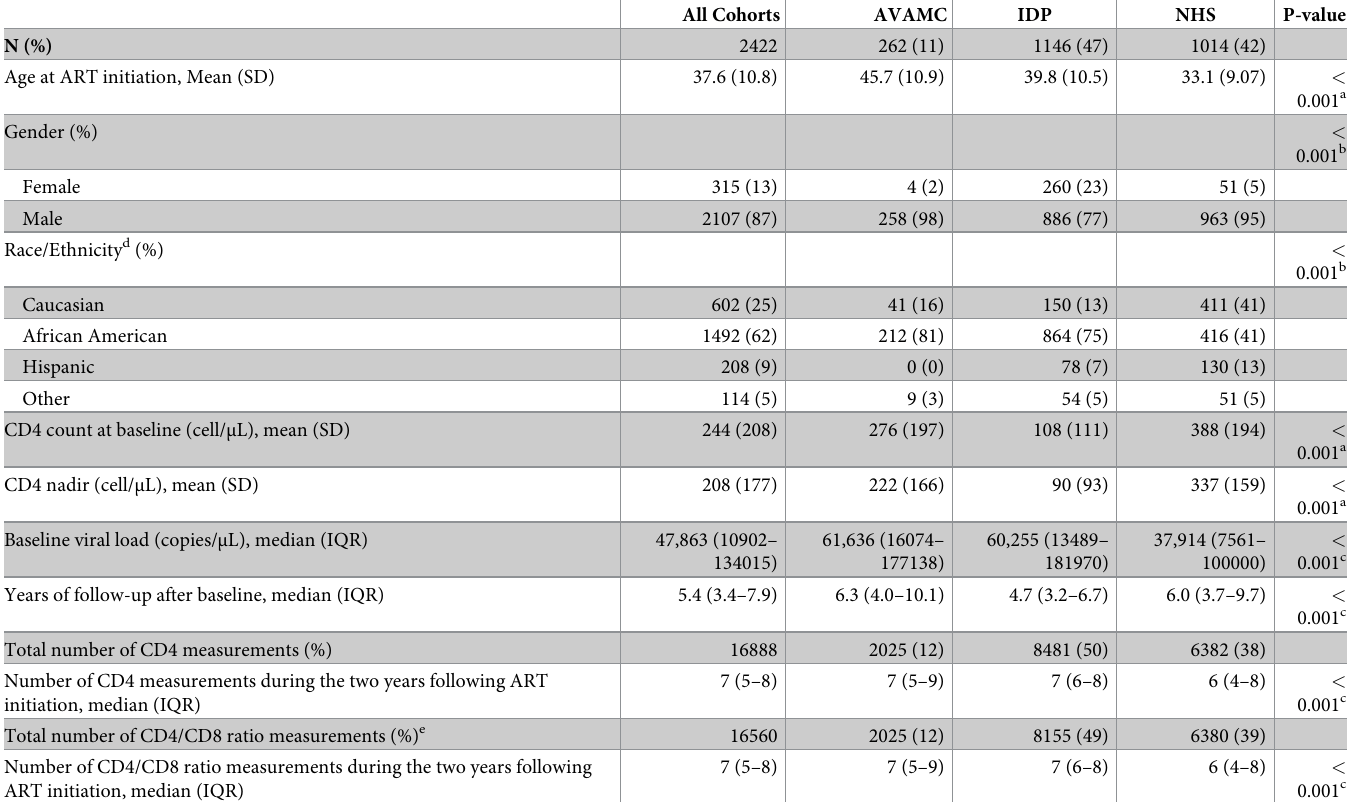
Table 1. Demographic and clinical characteristics by